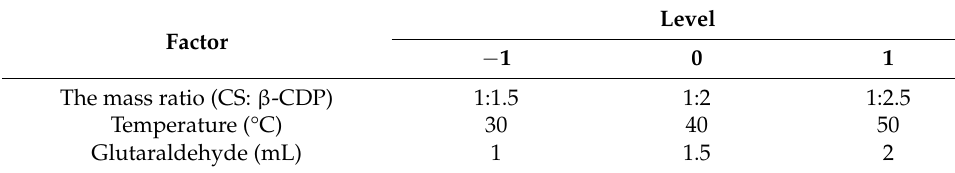
Table 1. Response Surface Design of Experiments.